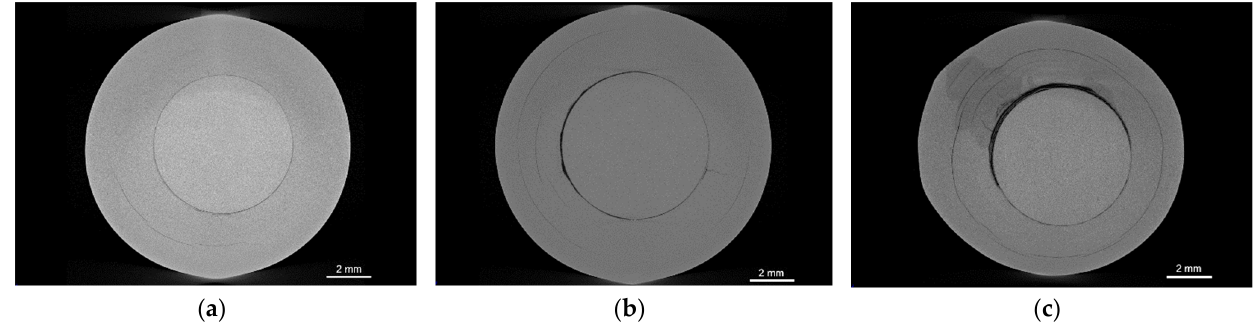
Figure 3. Cross- section μ -CT scanning images of pearl samples showing varying porosity, ( a ) sam- ple H-1; ( b ) sample Z-1; ( c ) sample C-1 Table 3. Porosity outside the nuclear of different pearl samples. Sample Number